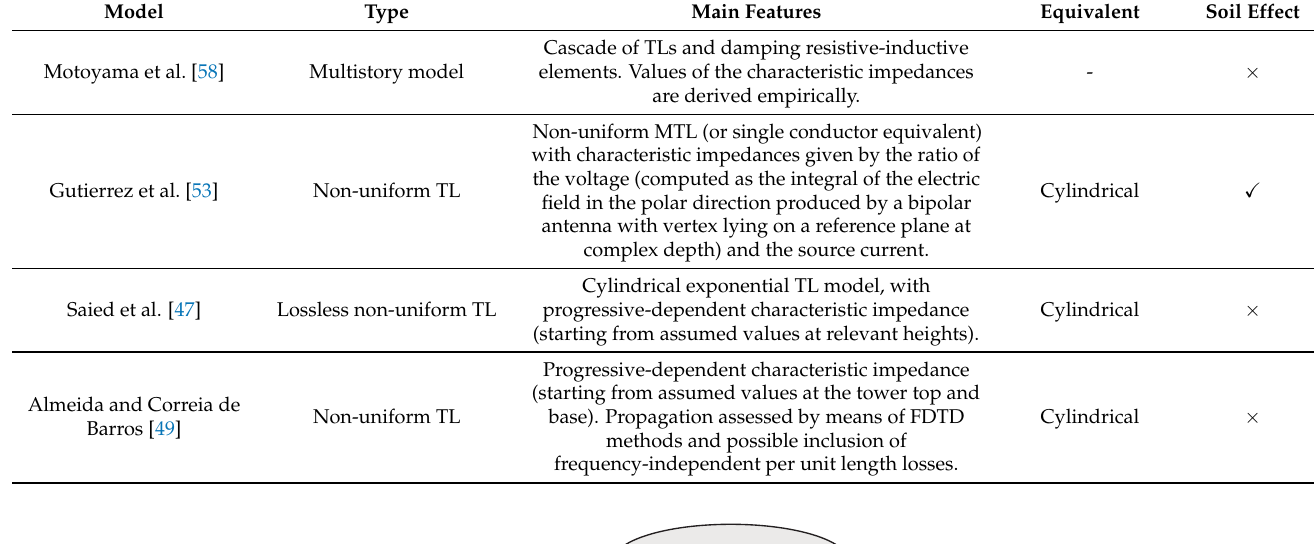
Table 3. Relevant tower models proposed in the literature (II).